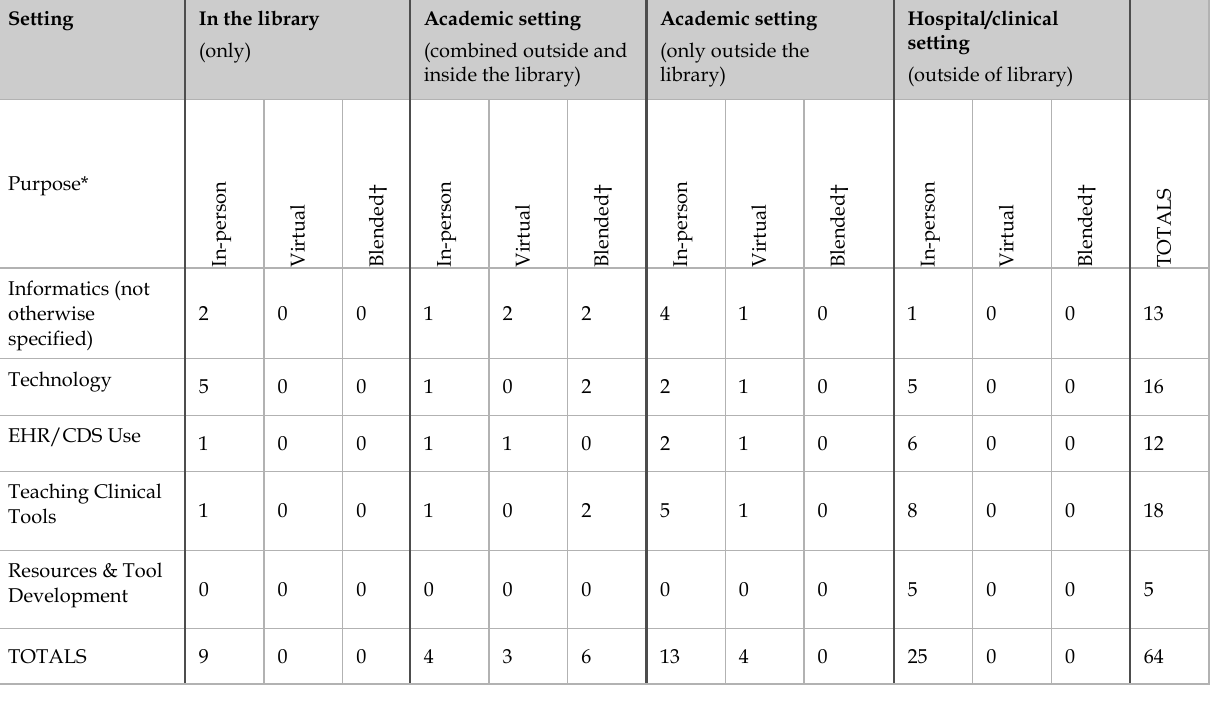
Table 2 Setting of educational activities (n=38) according to their purpose Setting In the library Academic setting (only) (combined outside and inside the library)